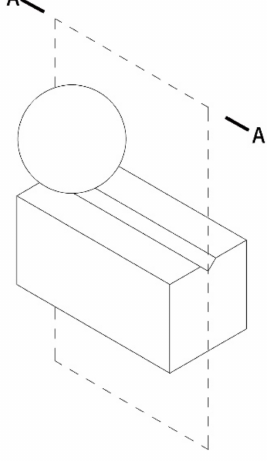
Figure 8. The 3D schematic of the PE wear